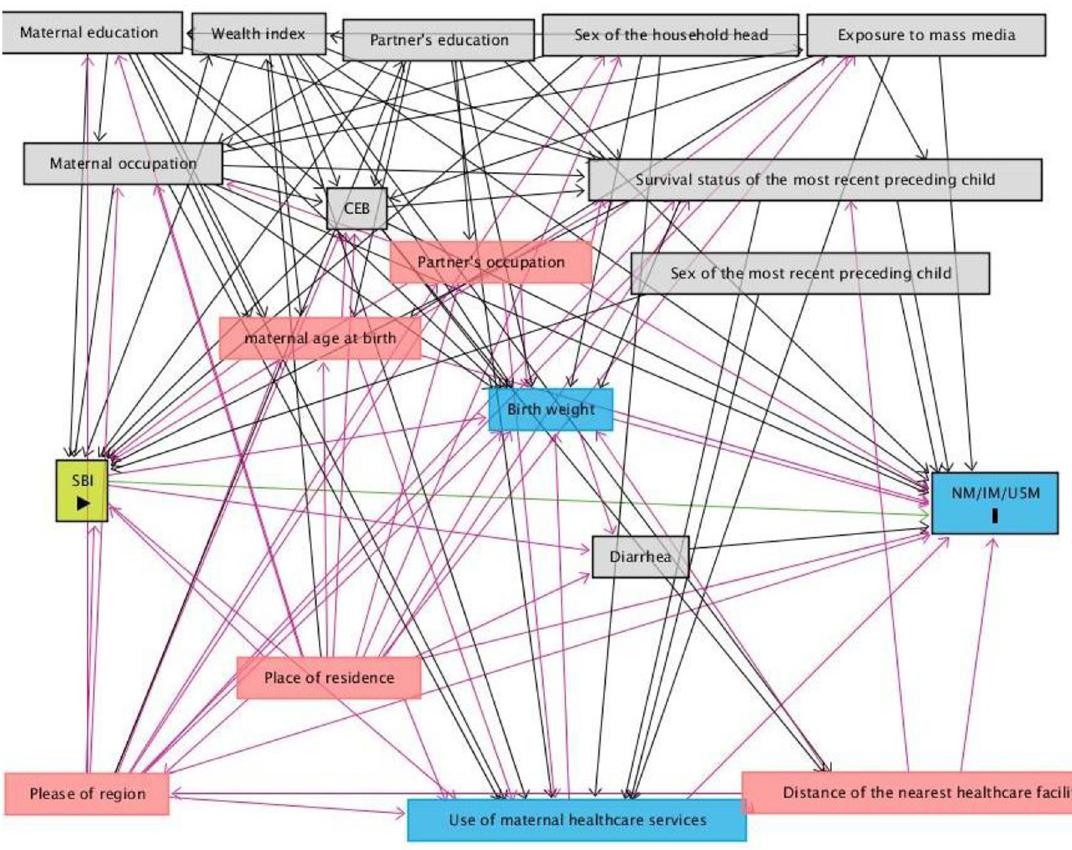
Fig 1. Direct acyclic graph used to select controlling variables to study the relationship of the short birth interval with neonatal, infant and under-five mortality. Note : CEB, children ever born, Nm, neonatal mortality, IM, infant mortality, and U5M, under-five